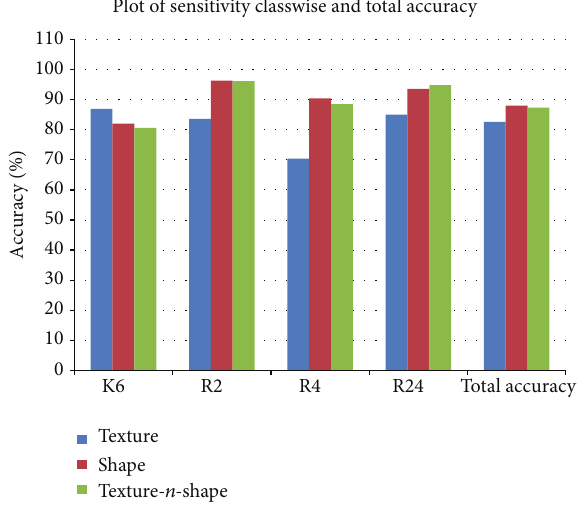
Figure 4: Plot of sensitivity